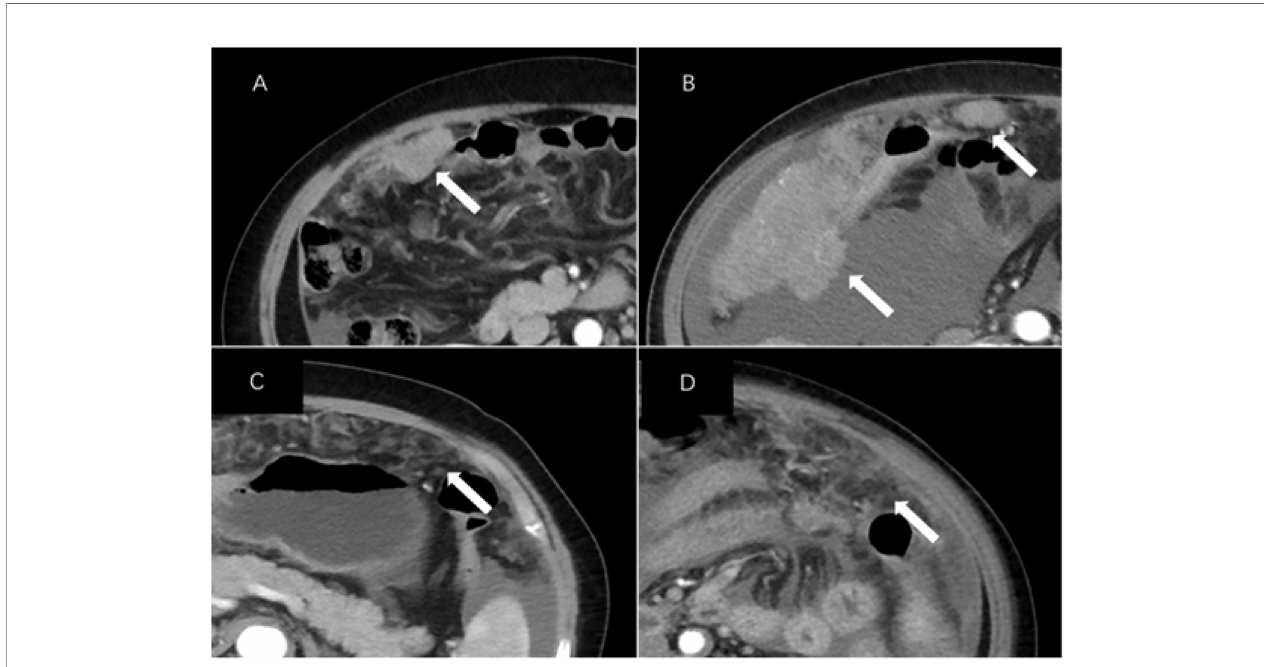
FIGURE 2 | CT images of peritoneal metastases in a patient with epithelial ovarian cancer. Axial CT images of (A) a 66-year-old woman and (B) a 76-year-old woman with BRCA mutations (stage III and IV, respectively) showing nodular lesions (arrows). Axial CT images of (C) a 66-year-old woman and (D) a 68-year-old woman with invasive cancer and wild-type BRCA (both stage III,